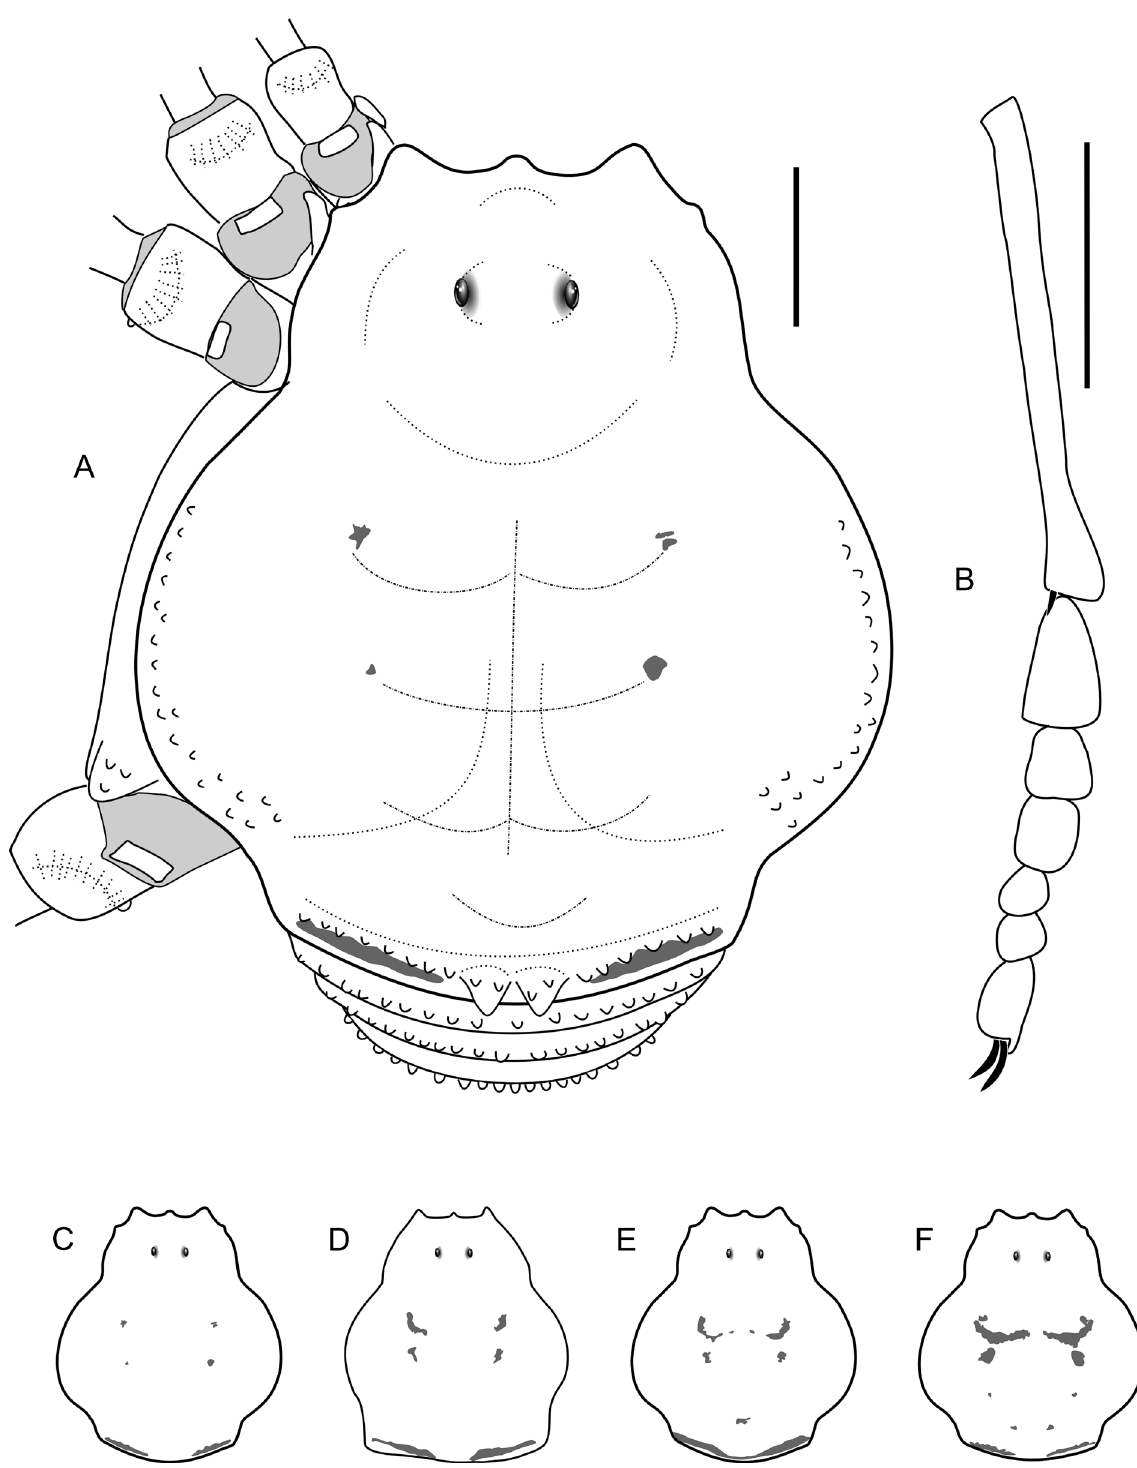
Fig. 24. Eulibitia pollux sp. nov., ♂, paratype (MNRJ 19369). A . Habitus, dorsal view. B . Left metatarsus and tarsomeres of leg I, prolateral view. C – F . Variation of spot pattern on dorsal scutum. C . ♂ (MNRJ 19369). D . ♀ (ICN-AO 422). E . ♂ (ICN-AO 422). F . ♂ (IAvH 97). Scale bars: 1